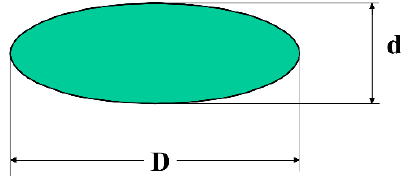
Figure 13. Anisometric solid particle.